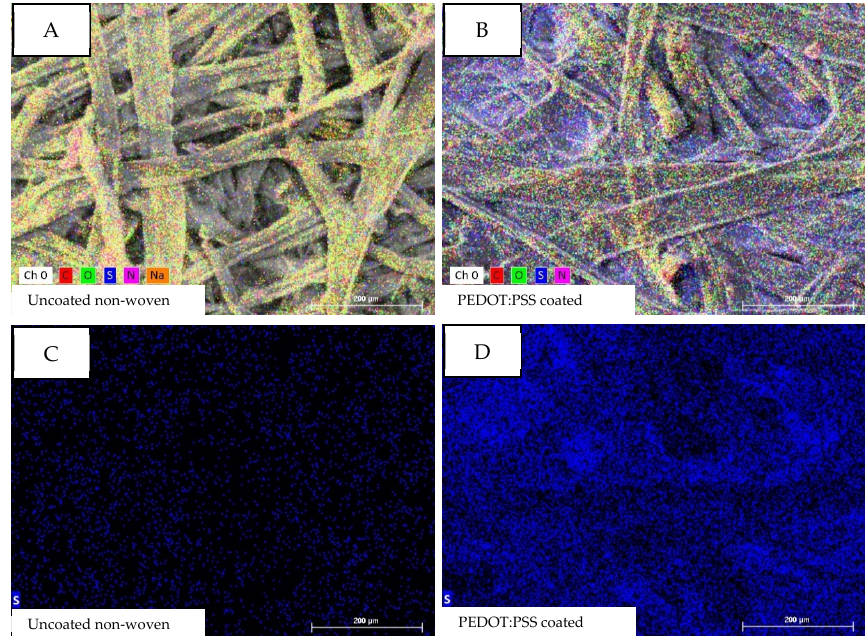
Figure 4. EDX analysis of ( A ) uncoated and ( B ) PEDOT:PSS-coated nonwoven material with special attention to the element sulfur in the uncoated ( C ) and coated sample ( D ). Table 1. EDX-data of uncoated and PEDOT:PSS-coated nonwoven material, showing an increase of atomic mass of sulfur.